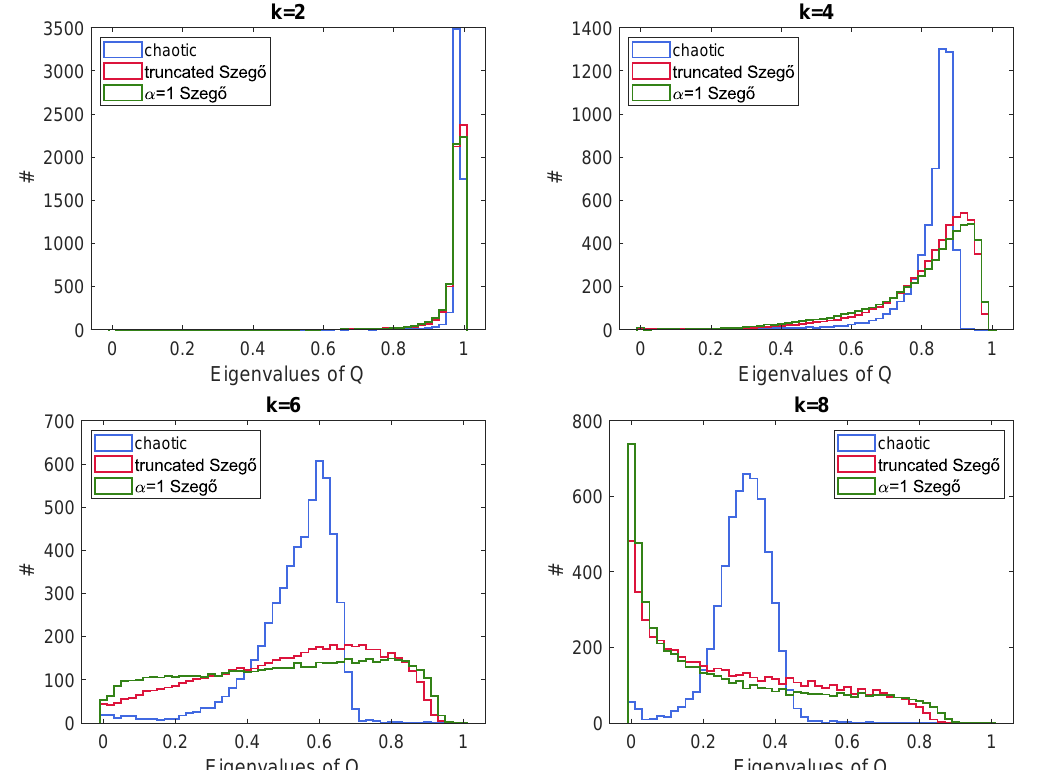
Figure 6: Histograms of the eigenvalues of the Q -matrix for a generic chaotic reso- nant Hamiltonian (blue), the integrable truncated Szeg˝o model (5.11) (red) and the integrable α -deformed Szeg˝o model (5.12) (green) for different values of the locality threshold k at N = M =